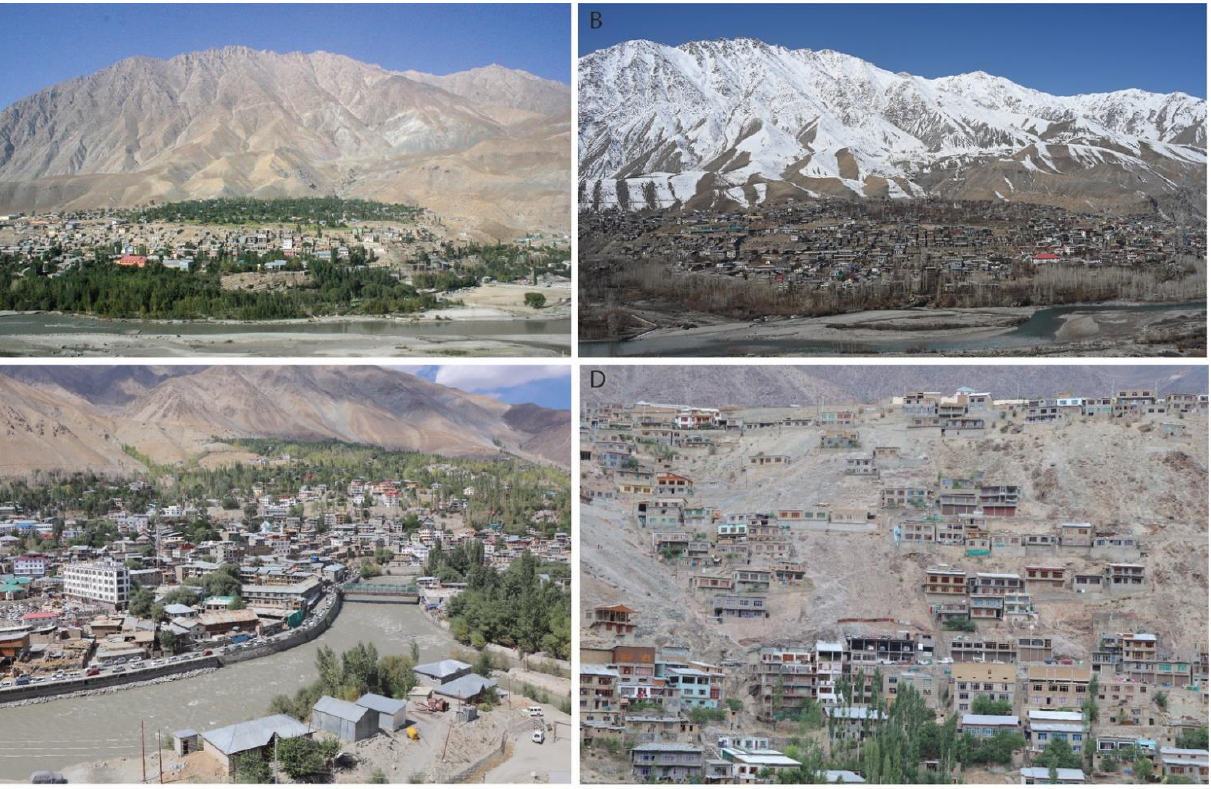
Figure 2. Photographs showing settlements of different areas in Kargil town. Top : Baroo and Baroo colony urban settlements along with cultivated fields at the upper part of Baroo on the opposite side of Suru River in August 2009 ( A ) and March 2023 ( B ). Middle : urban structure of Kargil town at the junction of Suru and Wakha rivers ( C ) and Andoo colony on steep slope area ( D ). Bottom : local bazaar of old town ( E ) and along National Highway-301 ( F ). Photos—( A ): Susanne Schmidt, August 2009, ( B ): Marcus Nüsser, March 2023; ( C – E ): Altaf Hussain, August and September 2021, 2022, ( F ): Susanne Schmidt, March 2023.